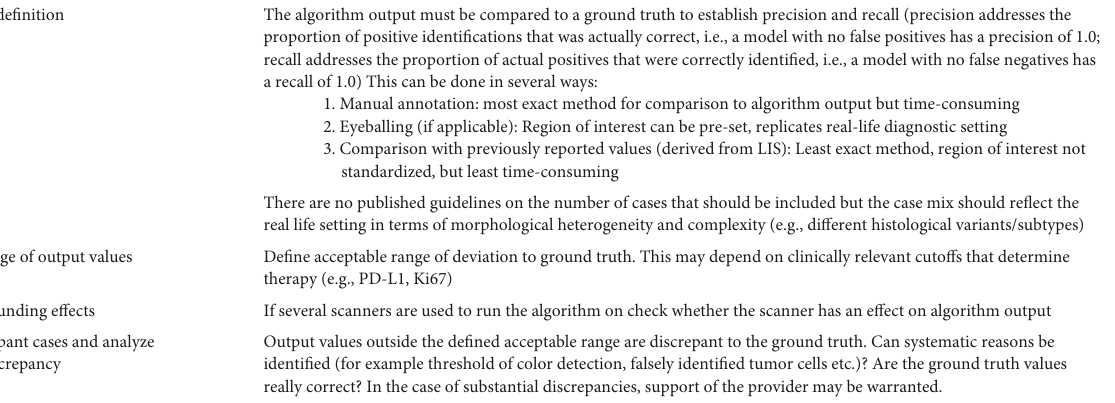
TABLE 3 Considerations for validation study design for image analysis tools. Ground truth